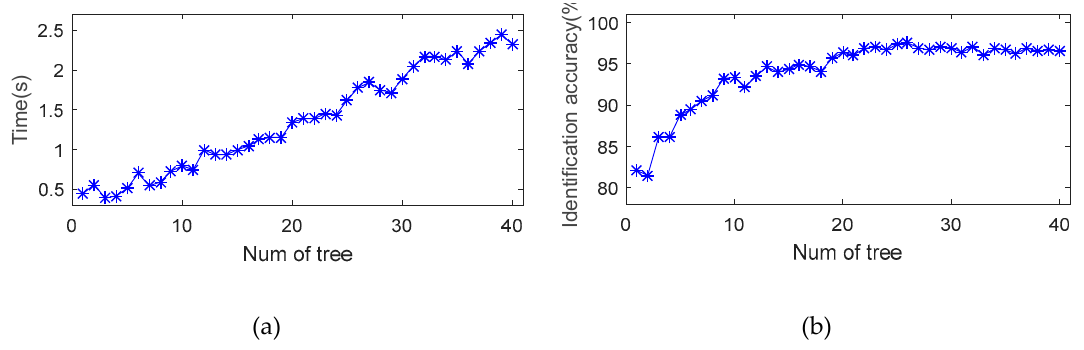
Figure 13. The curve of training time-13 ( a ) and detection accuracy-13 ( b ) with the increase in the number of trees.